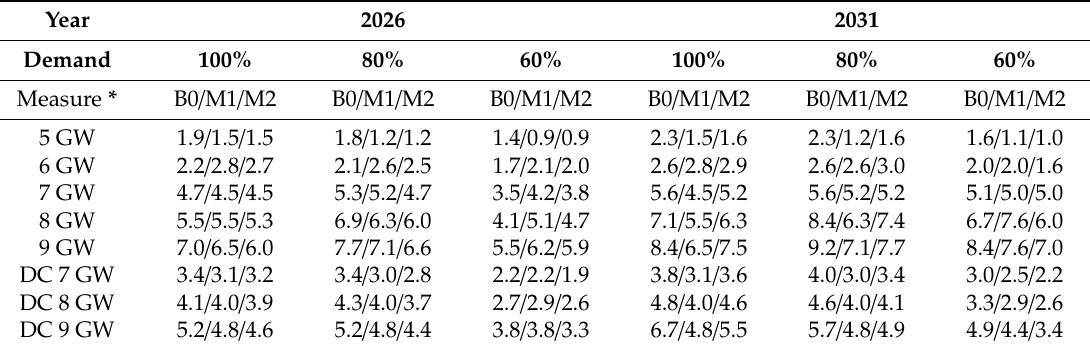
Table 19. The amount of reactive power compensation in 2026 and 2031 after